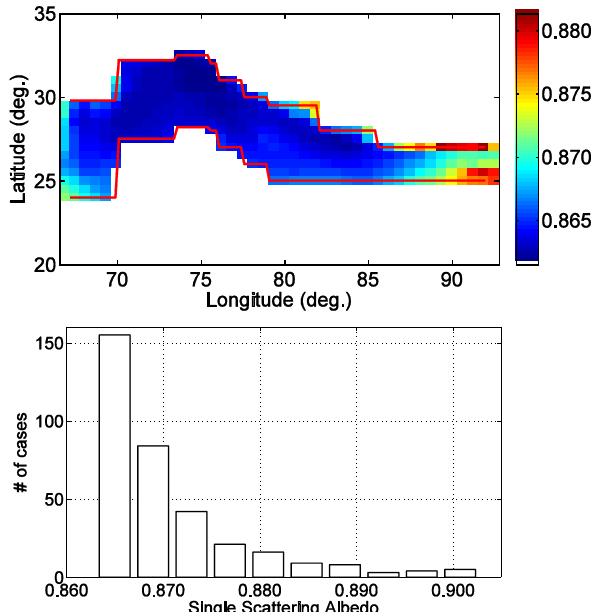
Figure 6. Spatial distribution (top) and frequency (bottom) of single scattering albedo values in the IGB averaged over MAM for the high absorbing aerosol years (2004, 2008, 2012) (from GOCART– MERRA, A. da Silva, personal communication,